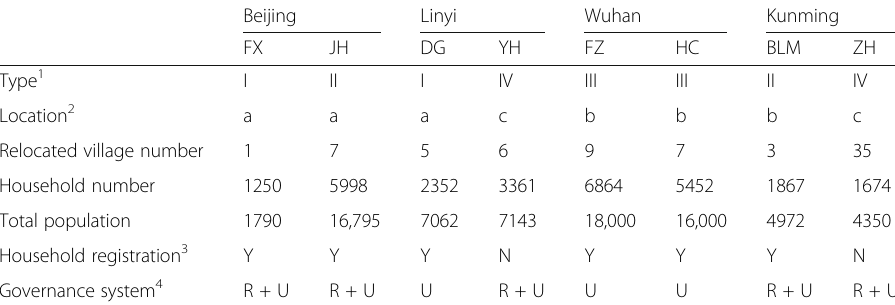
Table 1 General information for investigated